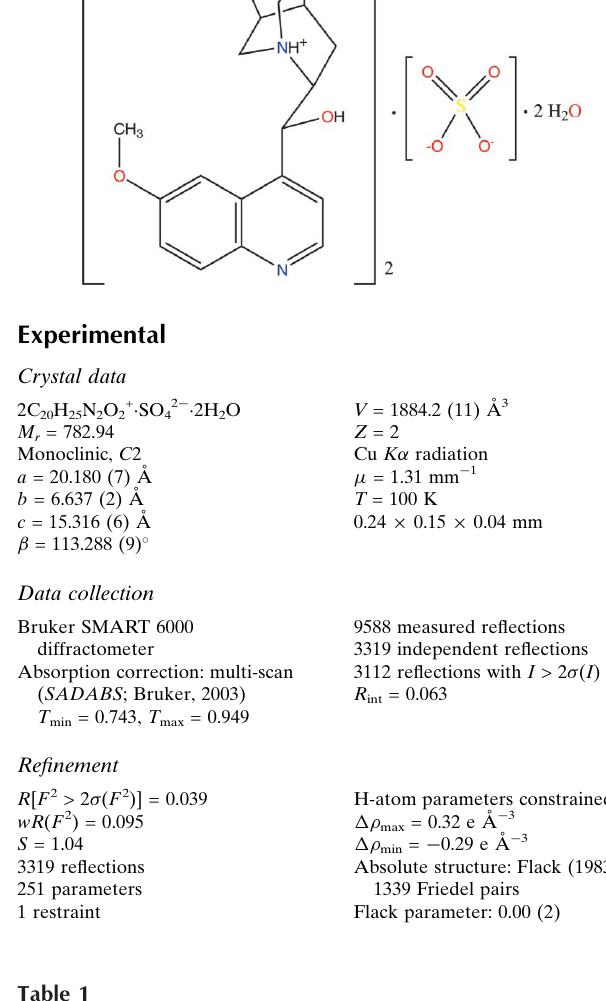
Hydrogen-bond geometry (A˚ , (cid:4) ). Cg 1 and Cg 2 are the centroids of the C2–C10 and N1–C5 rings,